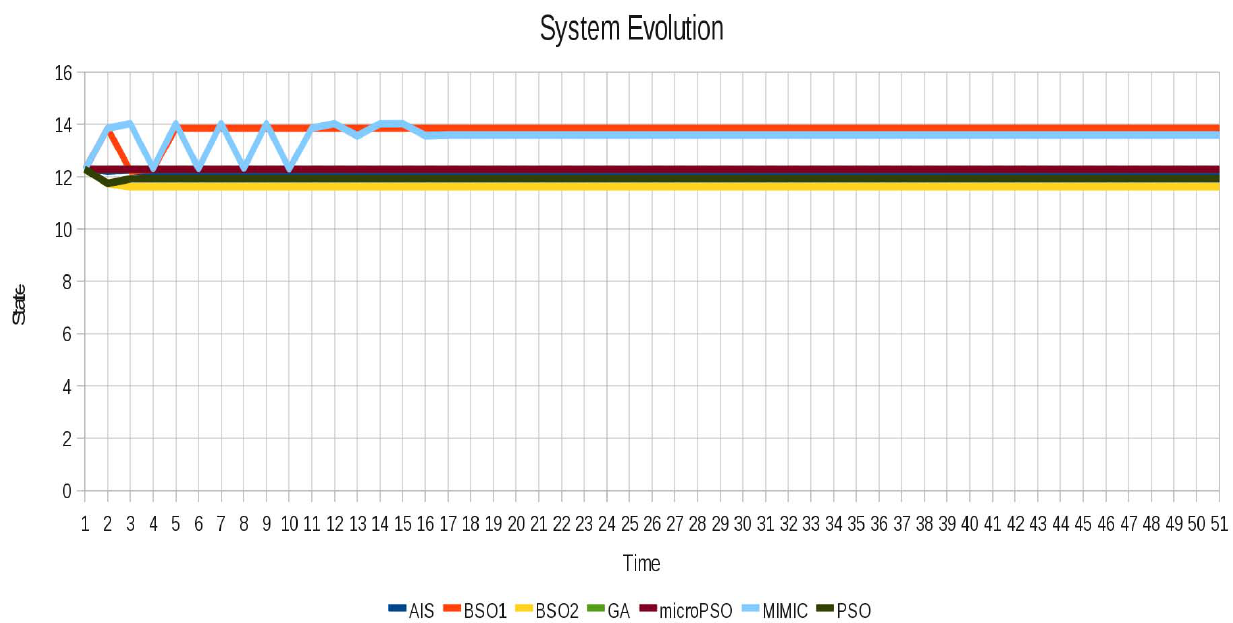
Figure 9. Behavior of the instance 2 (Non-oscillating) after locking with all algorithms.